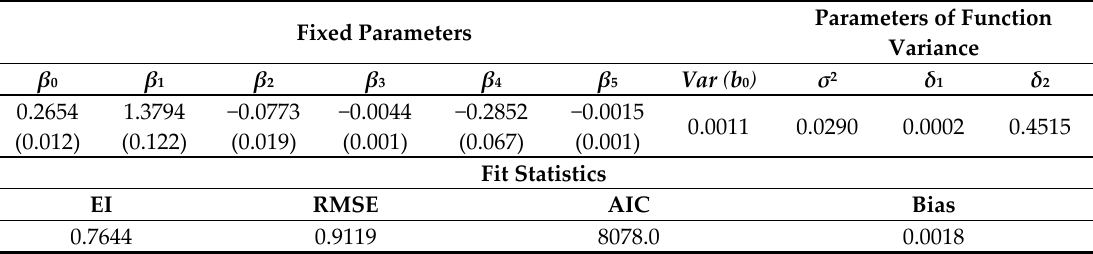
Table 7. Estimated parameters and fitting statistics of the GMM2.